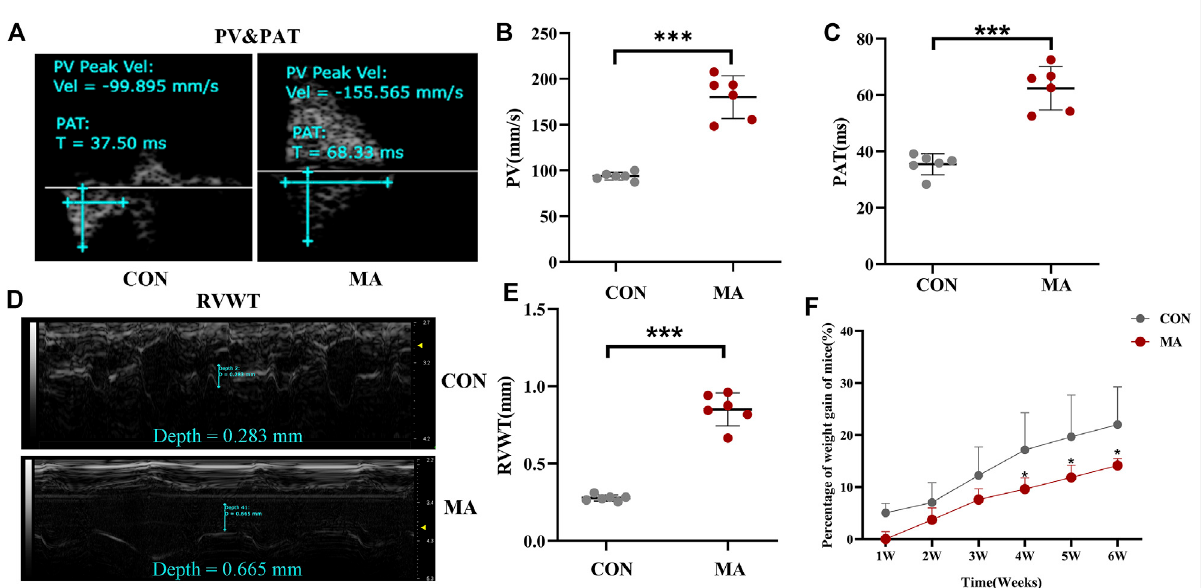
FIGURE 1 Hemodynamic analysis using transthoracic echocardiography and percentage of weight gain of mice. (A) The echocardiographic measurements for PV and PAT. (B) The PV in different groups. (C) The PAT in different groups. (D) The echocardiographic measurements for RV. (E) The echocardiographic measurements of RVWT in different groups. (F) Percentage of weight gain in the mice. N = 6. Data are expressed as mean ± standard deviation, * p < 0.05 vs.CON,** p < 0.01 vs.CON,*** p < 0.001 vs. CON. PV: Peakblood fl ow velocity ofthepulmonary artery, PAT: the acceleration time of pulmonary artery blood fl ow. RVWT: Right ventricular free wall thickness, CON: The control group, MA: mice treated with